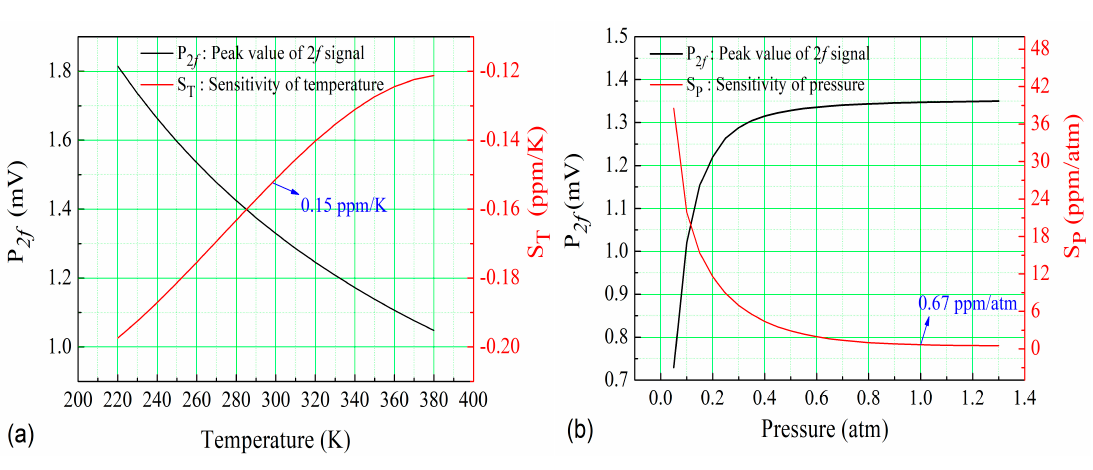
Figure 7. ( a ) 2 f signal intensity and temperature sensitivity at different temperatures; ( b ) 2 f signal intensity and pressure sensitivity at different pressures.